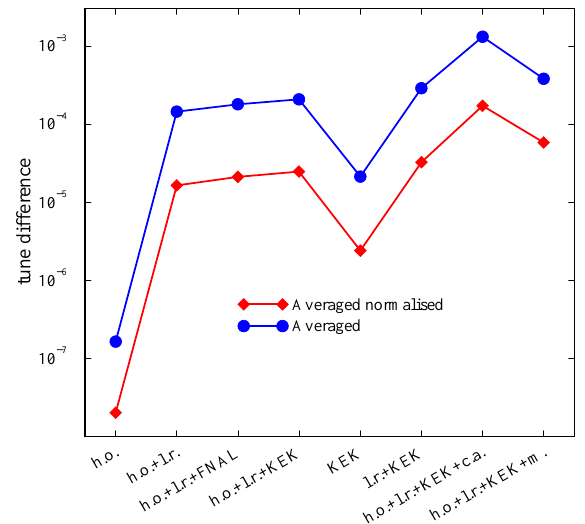
Averaged normalised Averaged